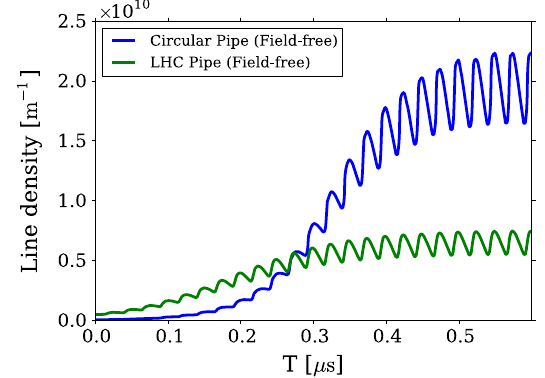
18. Electron cloud buildup in the realistic LHC pipe geometry (green) and in the circular geometry (blue). Bunch population is 10 11